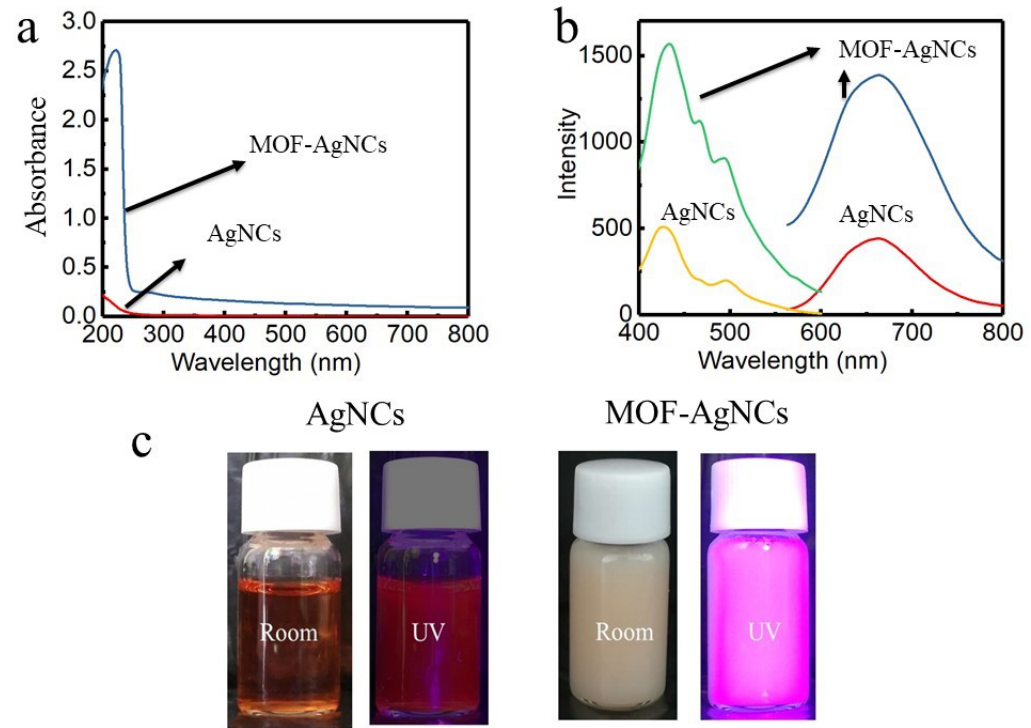
Figure 1. ( a ) UV-Vis, ( b ) fluorescence excitation (left), emission (right); ( c ) the corresponding photographs of AgNCs, and MOF-AgNCs at room and 365 nm UV light.